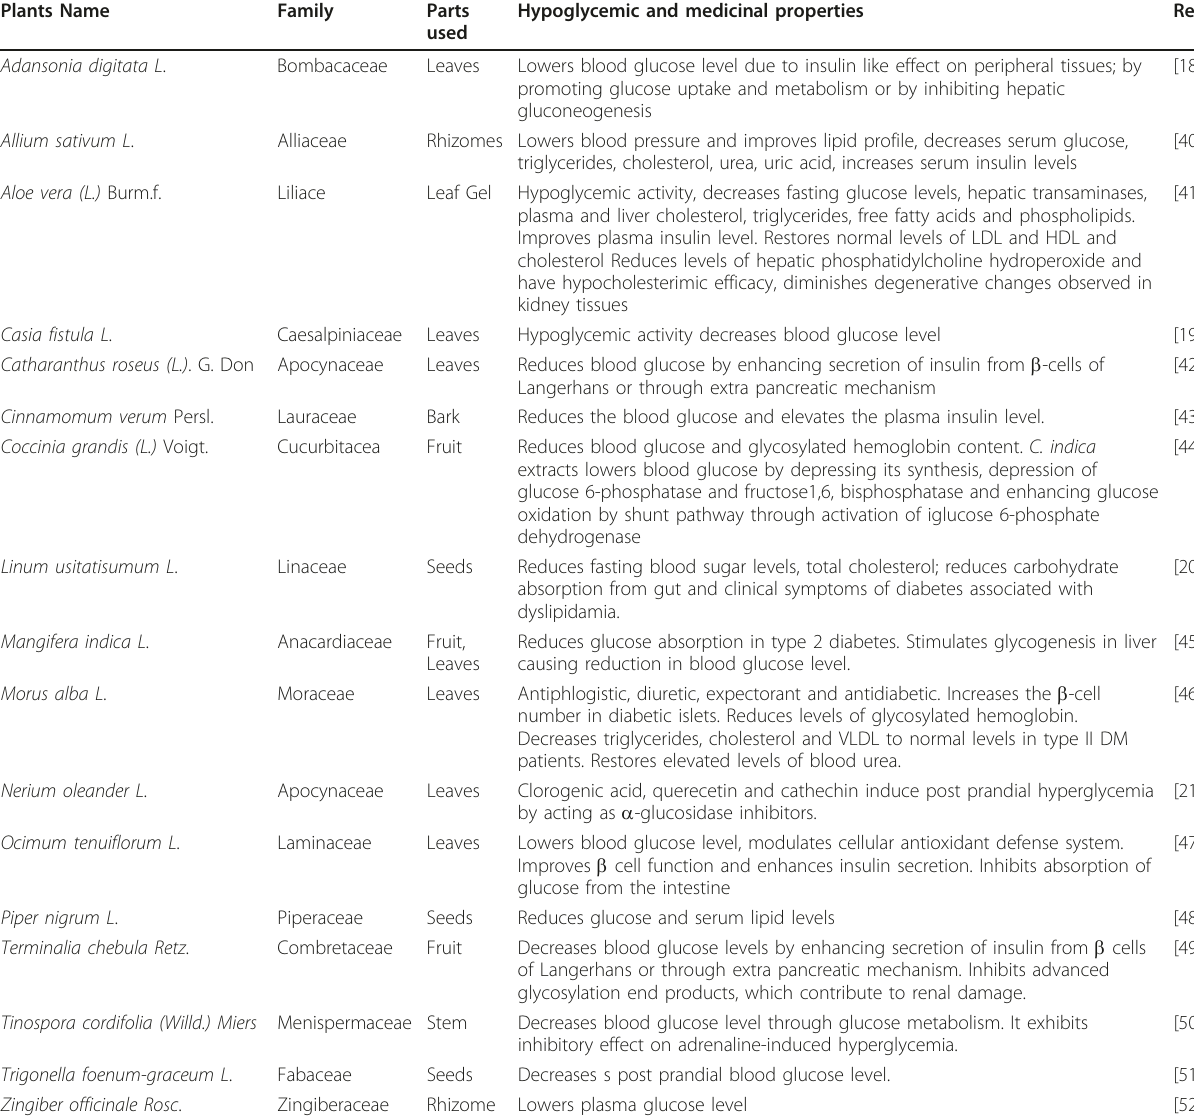
Table 1 Plant sources and their traditional uses Plants Name